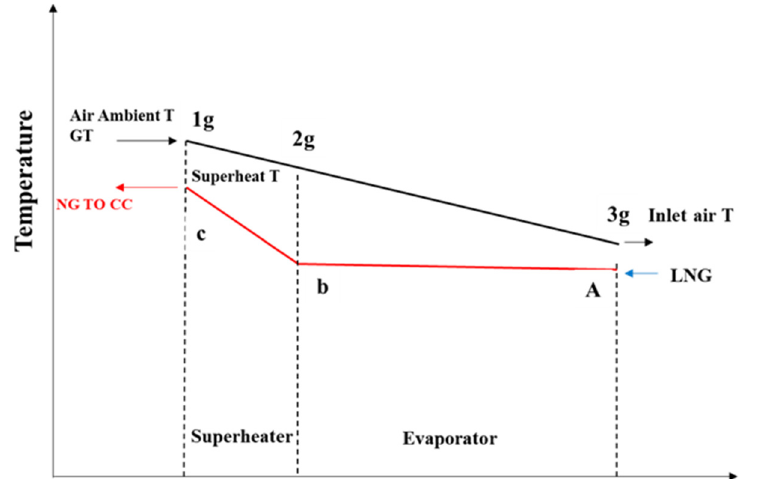
Figure 5. Heat balance in the heat exchanger between LNG and inlet air. 1g: inlet air mass flow temperature to heat exchanger; 2g: outlet air mass flow temperature from superheater stagnation to evaporator; 3g: outlet air mass flow temperature from heat exchanger to gas turbine; A: inlet LNG mass flow temperature to heat exchanger; b: outlet LNG mass flow temperature evaporator stagnation to superheater; c: outlet NG mass flow temperature from heat exchanger to combustion chamber gas turbine.